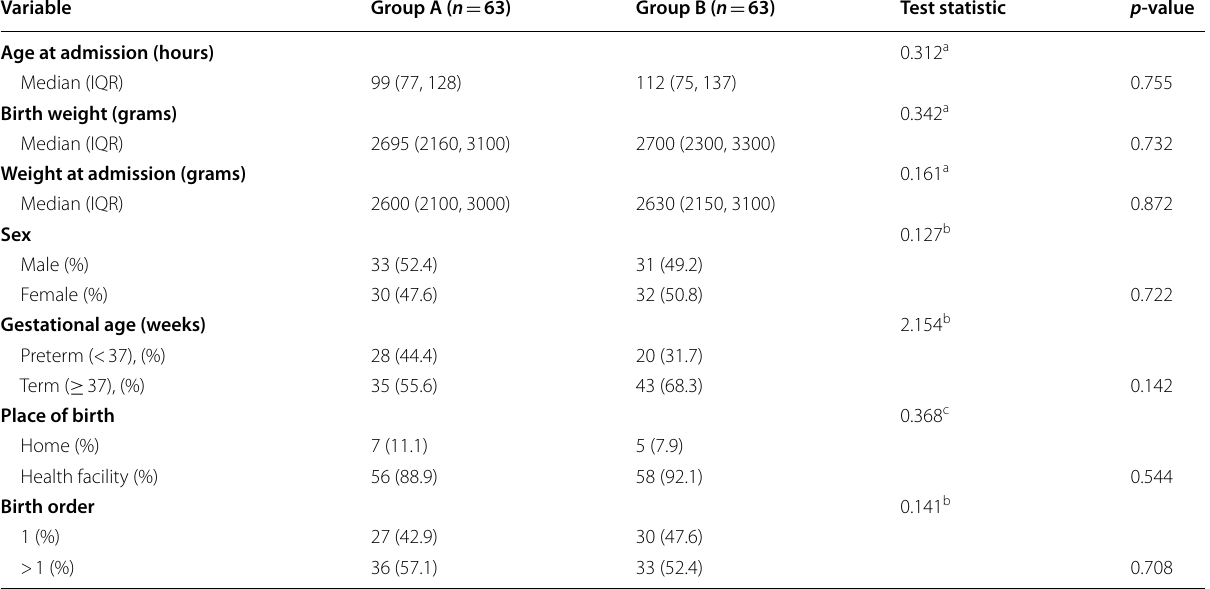
Table 1 Sociodemographic characteristics of the newborns